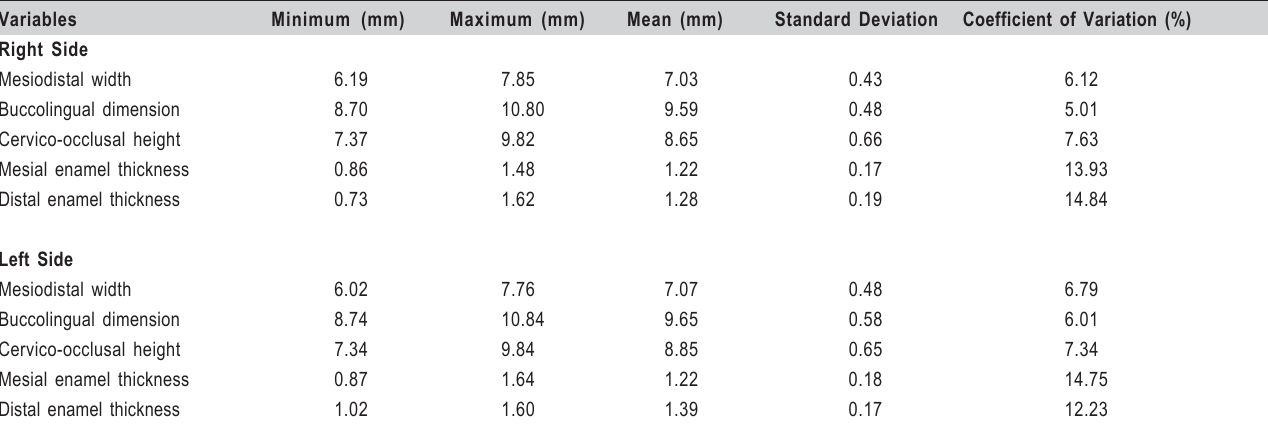
Table 1 - Measures of central tendency and dispersion relative to crown dimensions and proximal enamel thickness of maxillary first premolars (right teeth n = 20, left teeth n =